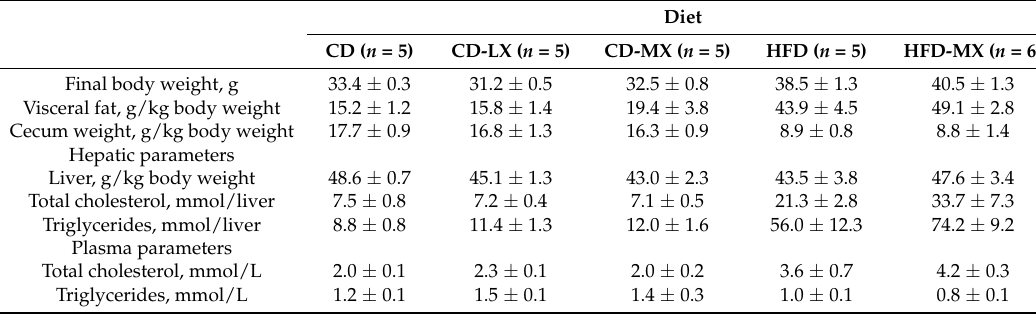
Table 2. Body weight, organ weight, and plasma parameters of mice fed the control diet or the high-fat diet with or without xylitol.